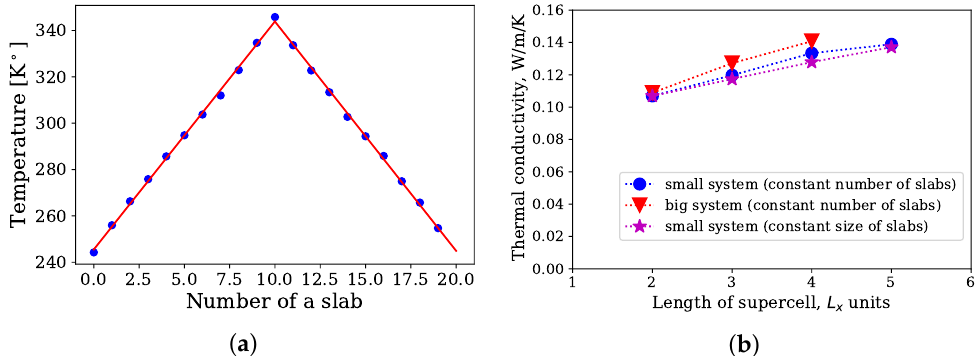
Figure 4. ( a ) Temperature profile inside the periodic supercell; ( b ) dependency of thermal conductiv- ities on the length of the periodic